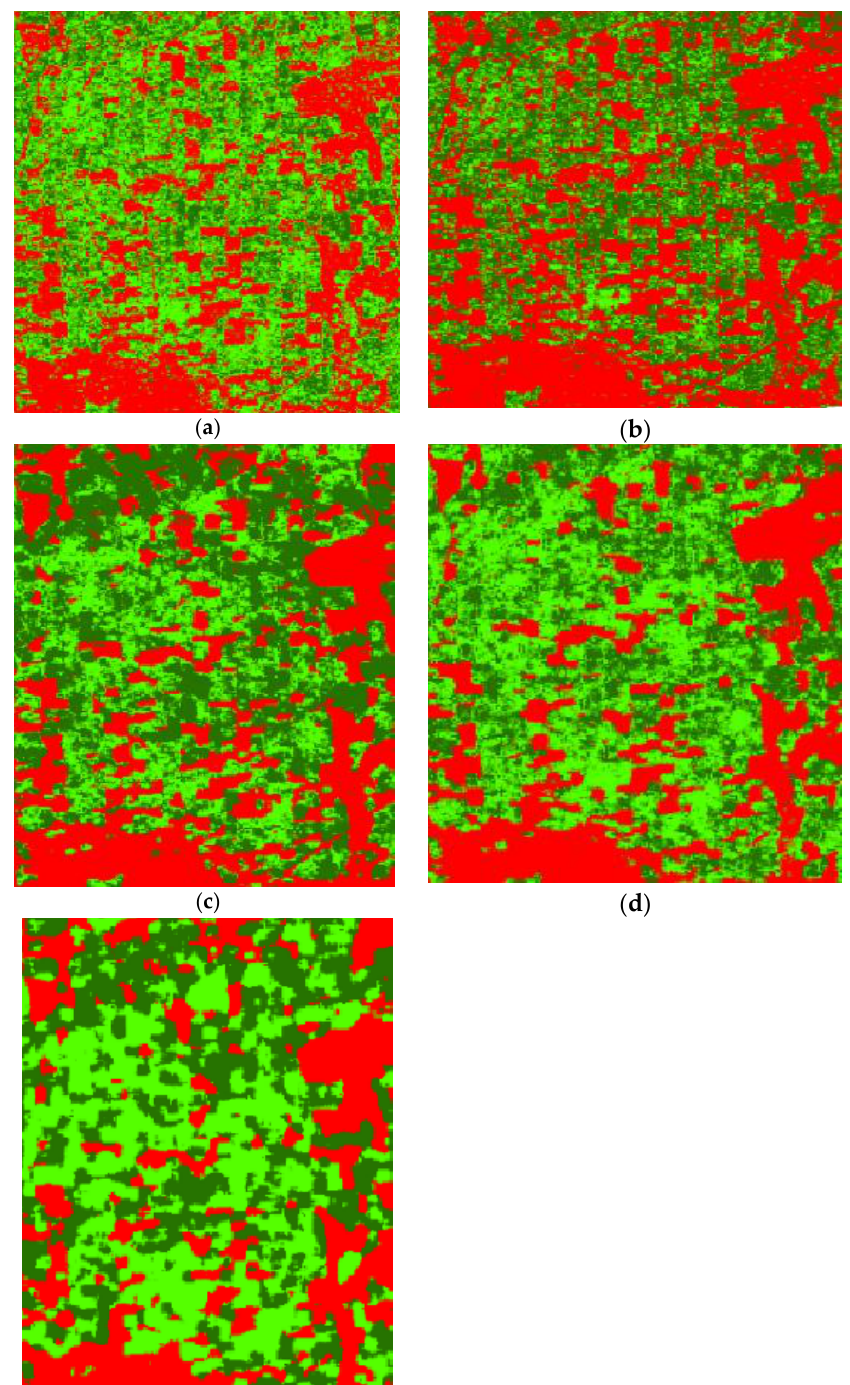
Figure 9. Zoom of the results of crop mapping methods: ( a ) RF, ( b ) XGBOOST, ( c ) 2-CNN, ( d ) 3-CNN, and ( e ) the proposed method.